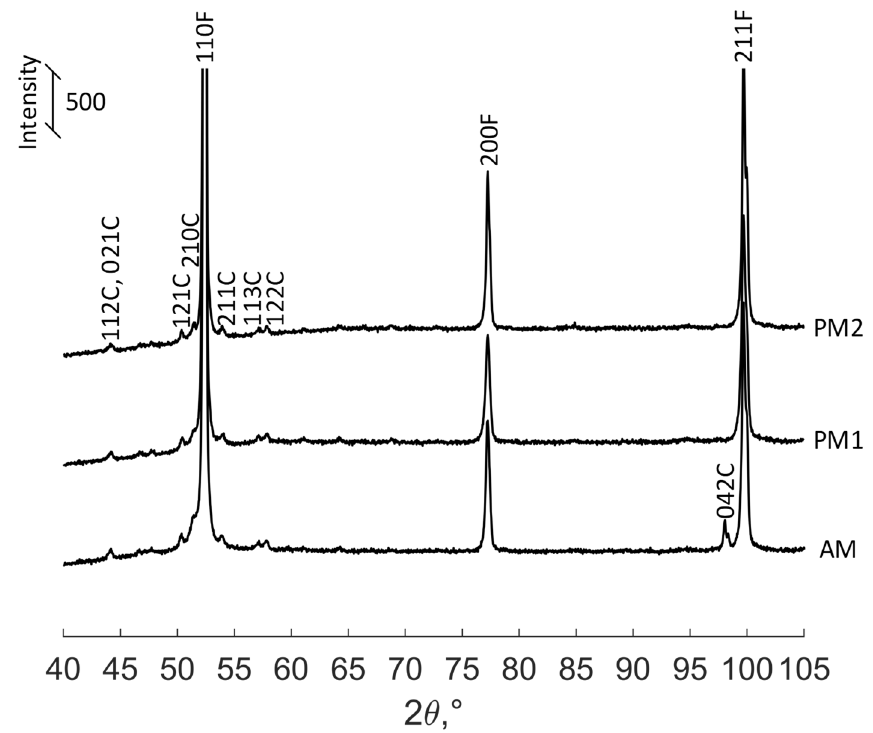
Figure 10. XRD diffractograms of the AM and PM specimens. Figure 10. XRD di ff ractograms of the AM and PM